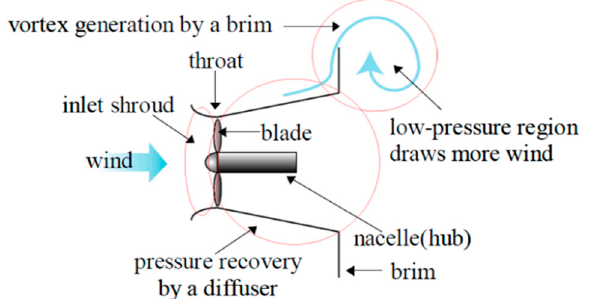
Figure 1. Wind lens turbine (WLT) mechanism.